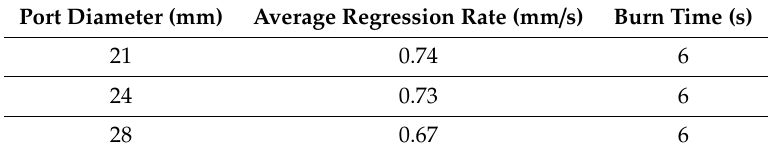
Table 1. Average regression rate for the varying port diameter using multi-angle diverging injector.